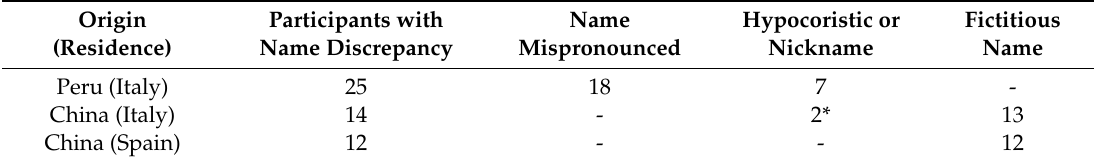
Table 2. Forms of disparity between the documented name of the immigrant and the one used in the host